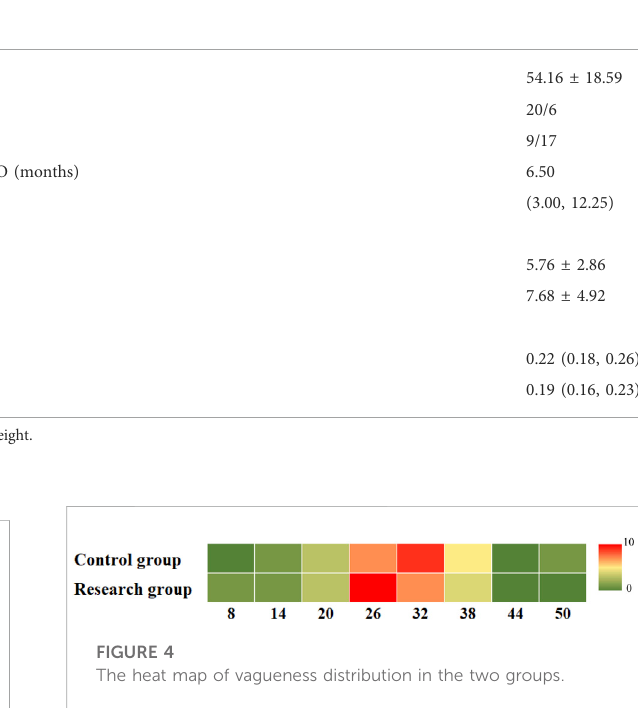
TABLE 1 Demographic features and baseline characteristics.